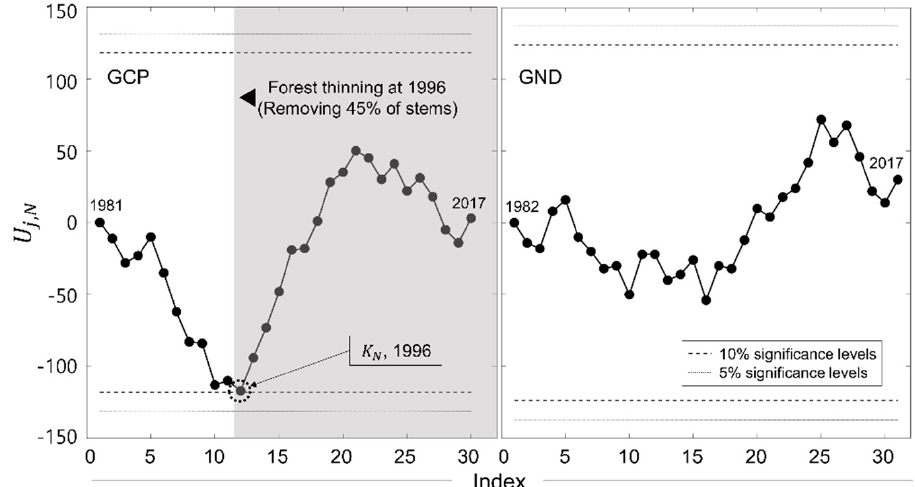
Figure 4. Pettitt’s test of the GCP and GND forest catchments. The test statistics of the GCP forest